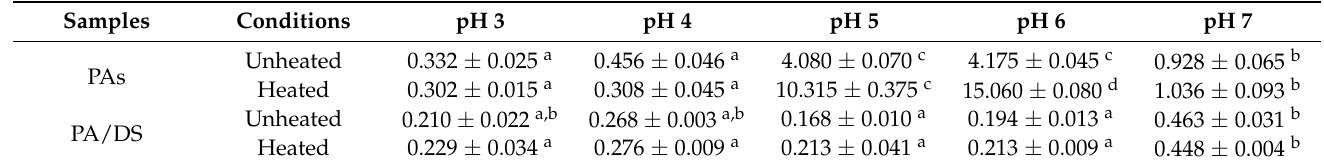
Table 3. Effect of pH and heat treatment on particle size (d 4, 3 , µ m) of emulsions stabilized by PAs alone and PA/DS soluble